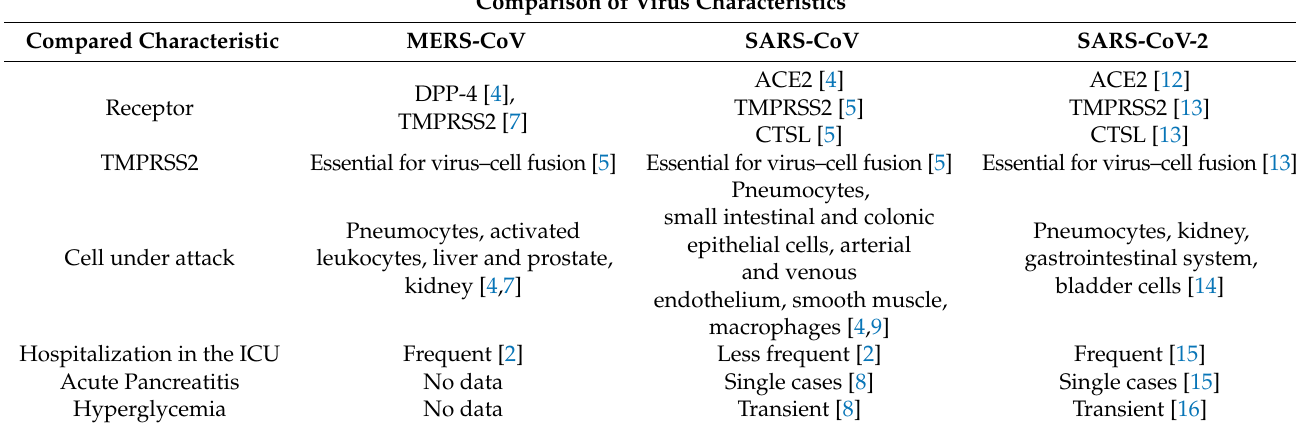
Table 1. The summary of characteristics of SARS and MERS coronaviruses. Dipeptidyl peptidase-4 (DPP4), transmembrane protease serine 2 (TMPRSS2), hospitalization in the intensive care unit (ICU), and cathepsin L (CTSL). Comparison of Virus